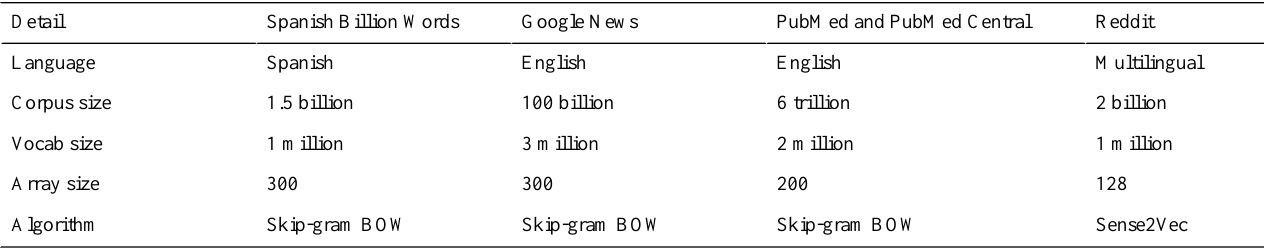
RedditPubMed and PubMed CentralGoogle NewsSpanish Billion WordsDetail